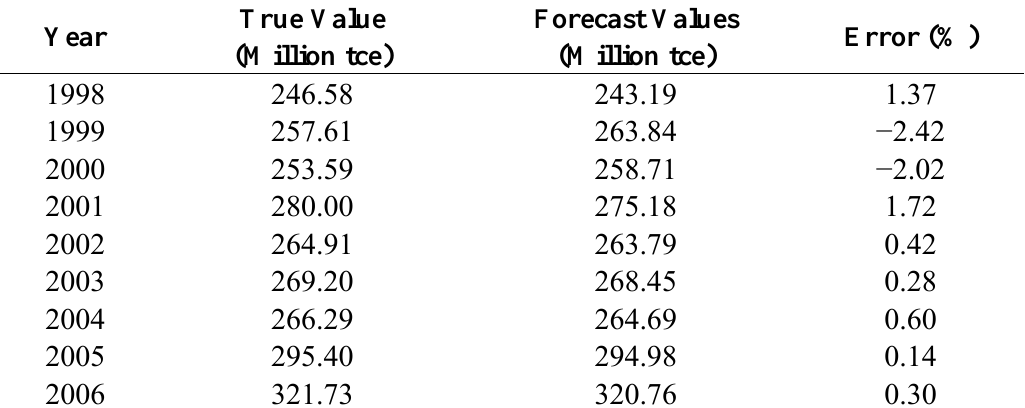
Table 4. Life energy consumption forecasts for real values and forecast